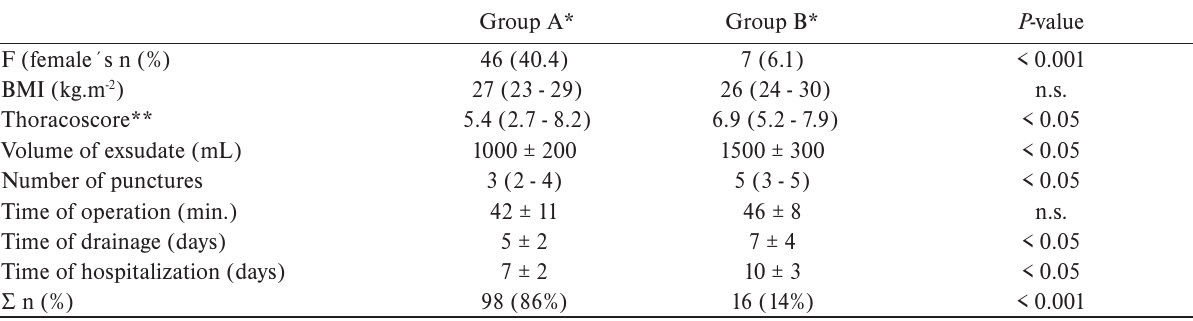
Table 2. Demographic data (N =